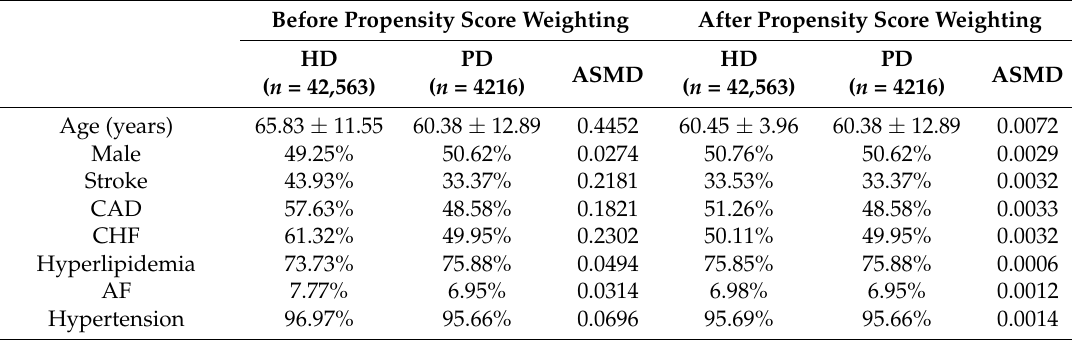
Table 1. Baseline characteristics at starting dialysis among diabetic kidney patients undergoing hemodialysis and peritoneal